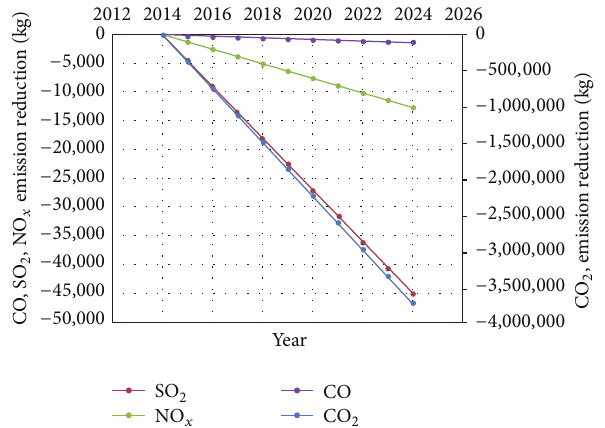
Figure 7: Pattern of emission reduction of CO 2 , SO 2 , NO 𝑥 , and CO by electricity generation from 0% to 100%